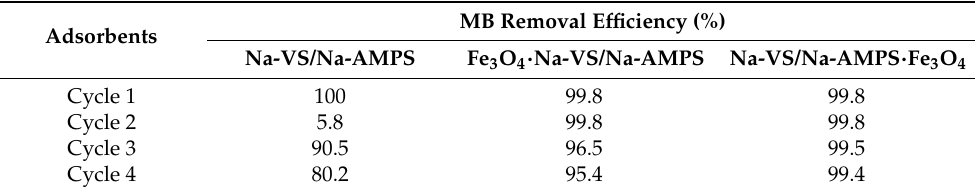
Table 4. Reuse Na-VS/Na-AMPS cryogel and its composites for removal of 1 m mol · L − 1 of MB aqueous solution at 298